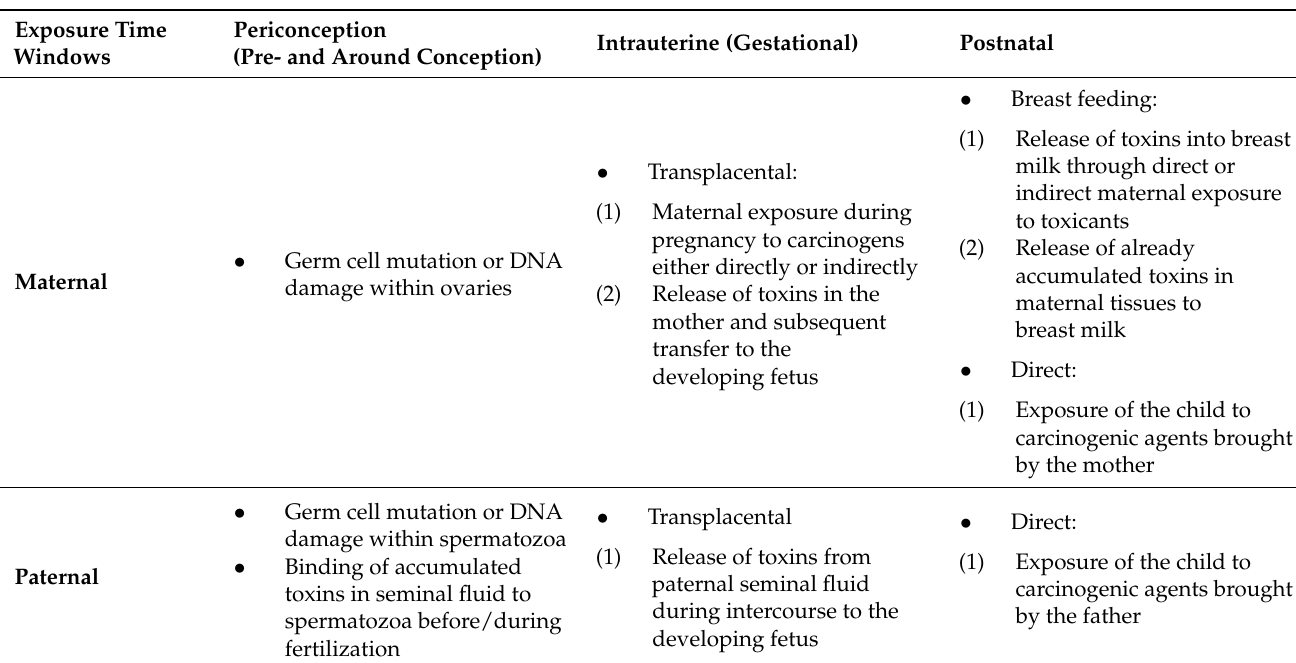
Table 3. Framework for biological mechanisms of childhood cancer in relation to exposure time windows via maternal and paternal